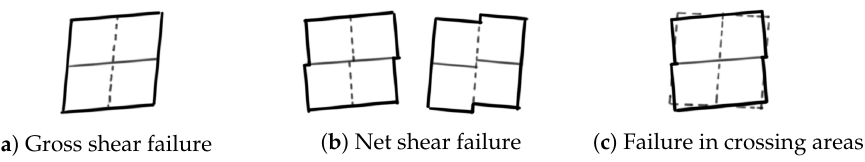
Figure 5. Failure modes of shear walls according to Danielsson et al. [14]. Redrawn and adapted by the authors.